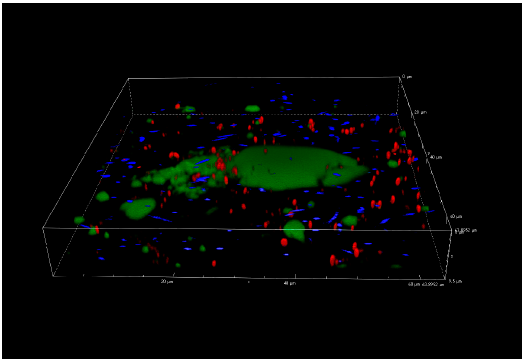
Figure 5. Confocal Laser Scanning Microscopy (CLSM) analysis of L. monocytogenes LM5 and P.